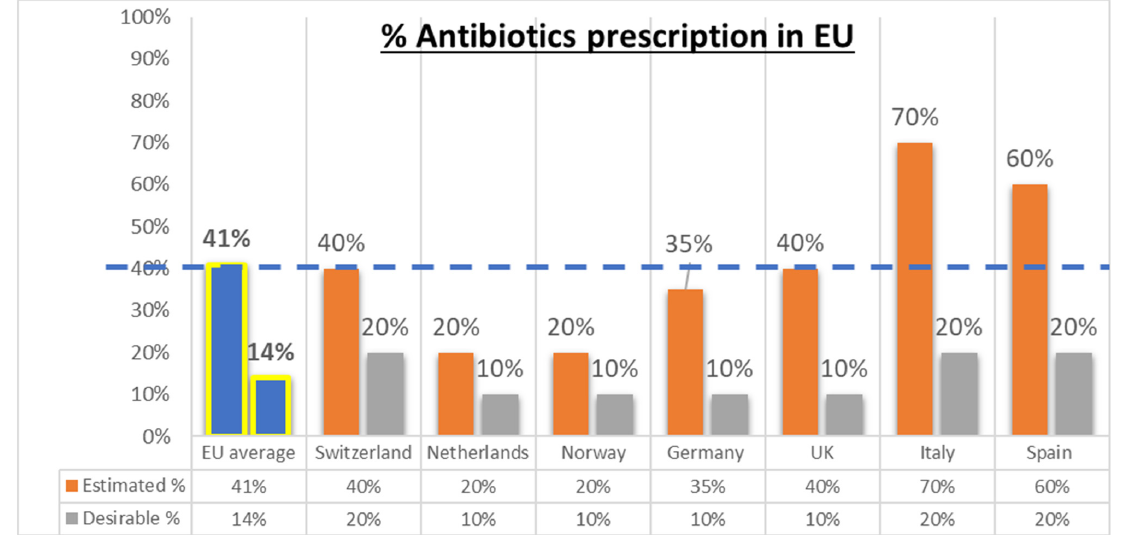
4 of 16 Figure 1. Summary of key findings from the Expert Panel regarding the utility of CRP POC testing in LRTIs. 3.1. CRP POC Testing as a Pillar in the Fight against Antibiotic Over-Prescription The Expert Panel estimated that the current rate of antibiotic prescription for LRTIs